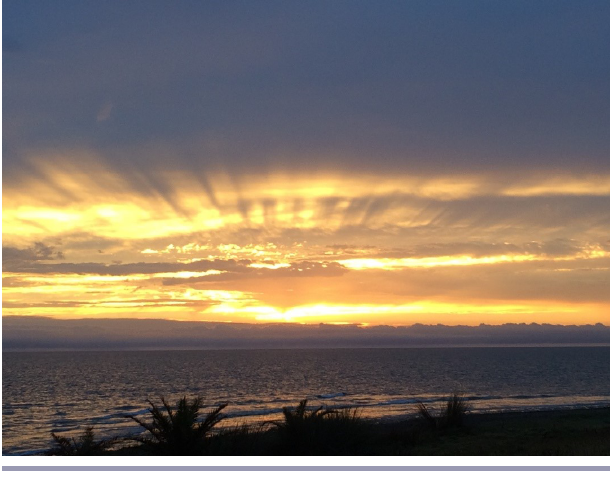
Fig. 3. Sunset at the Board meeting in December 2016.